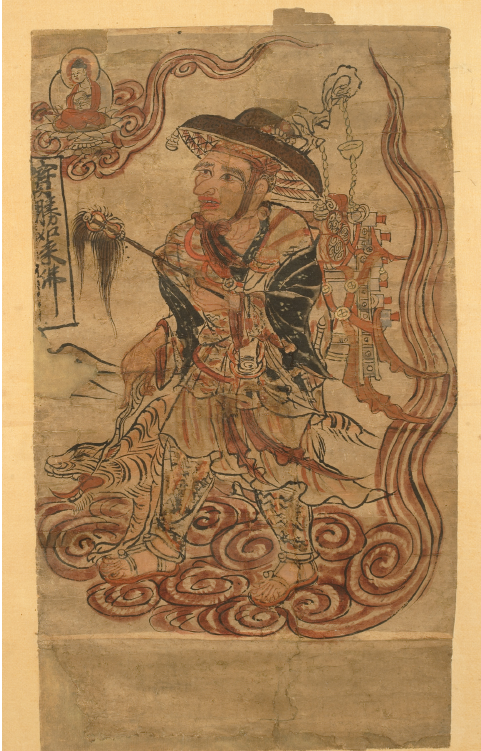
Figure 7 Figure 7. Itinerant Monk . Dunhuang, 10th century. Ink and colors on paper, 51.8 × 29. 3 cm. Inv. No. Dh-320. The State Hermitage Museum, St. Petersburg. Photograph © The State Hermitage Museum, Photo by Leonard